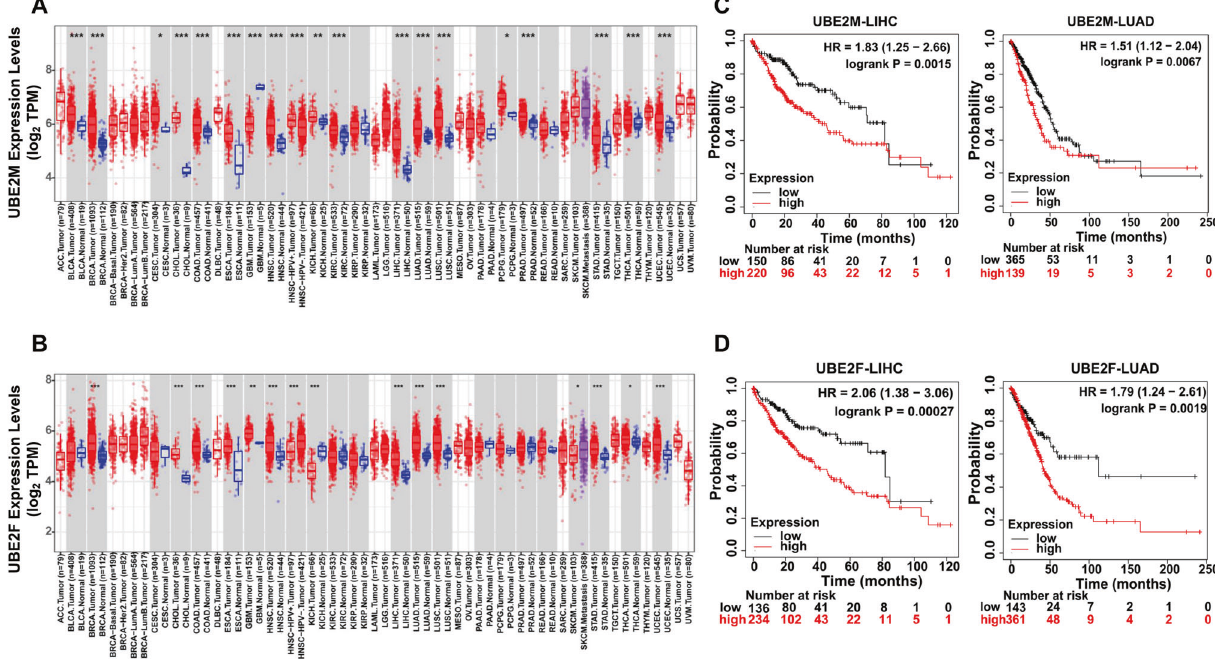
Fig. 3 Expression of UBE2M and UBE2F in cancers and their effects on the prognosis of patients with LUAD and LIHC. A , B The expression of UBE2M and UBE2F in different types of cancer was investigated with the TIMER database. The variance was similar between the groups that were being compared. P < 0.05 was considered as statistical signi fi cance. * P < 0.05, ** P < 0.01, *** P < 0.001 for the indicated comparison. C , D Kaplan-Meier analysis shows that increased levels of both UBE2M and UBE2F are related to worse survival for patients with lung adenocarcinoma (LUAD) or with liver hepatocellular carcinoma (LIHC).